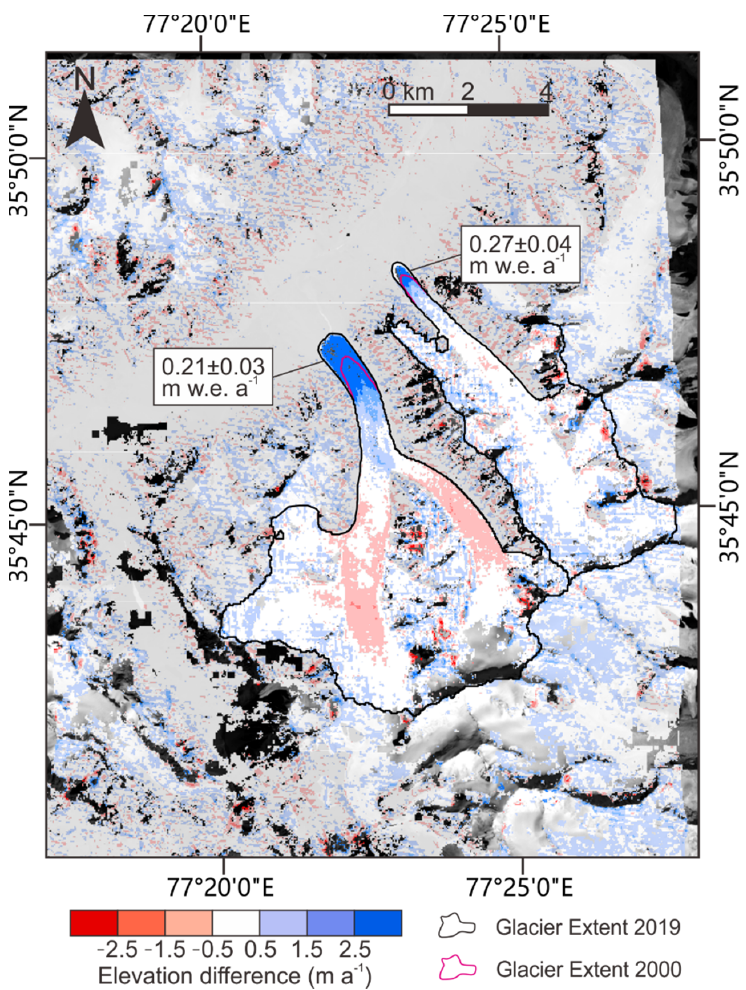
Figure 5. Map of annual elevation change over studied area with indication of glacier mass balance. The background is a Landsat 8 panchromatic image.